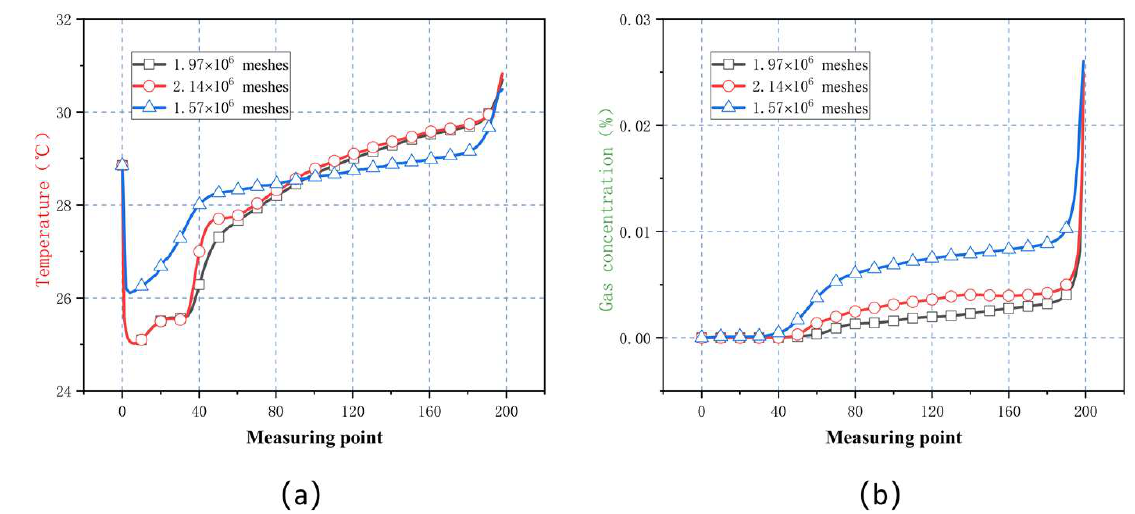
Figure 5. Temperature vs. gas concentration data curve along the working face. ( a ) temperature curve; ( b ) gas concentration curve.